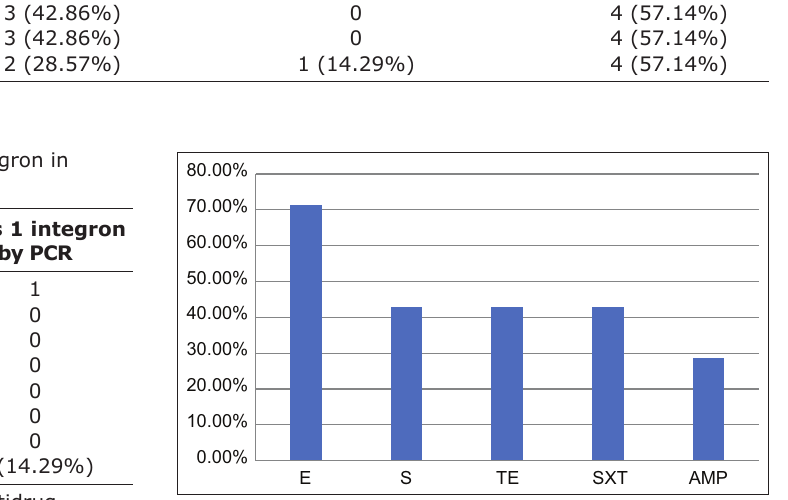
C. freundii = Citrobacter freundii , MDR = Multidrug resistant, R = Resistant, PCR = Polymerase chain reaction Figure-1: Antibiotic resistance pattern of Citrobacter freundii isolated from laying chickens. E=Erythromycin, S=Streptomycin, TE=Tetracycline, SXT=Trimethoprim- sulfamethoxazole, AMP=Ampicillin.